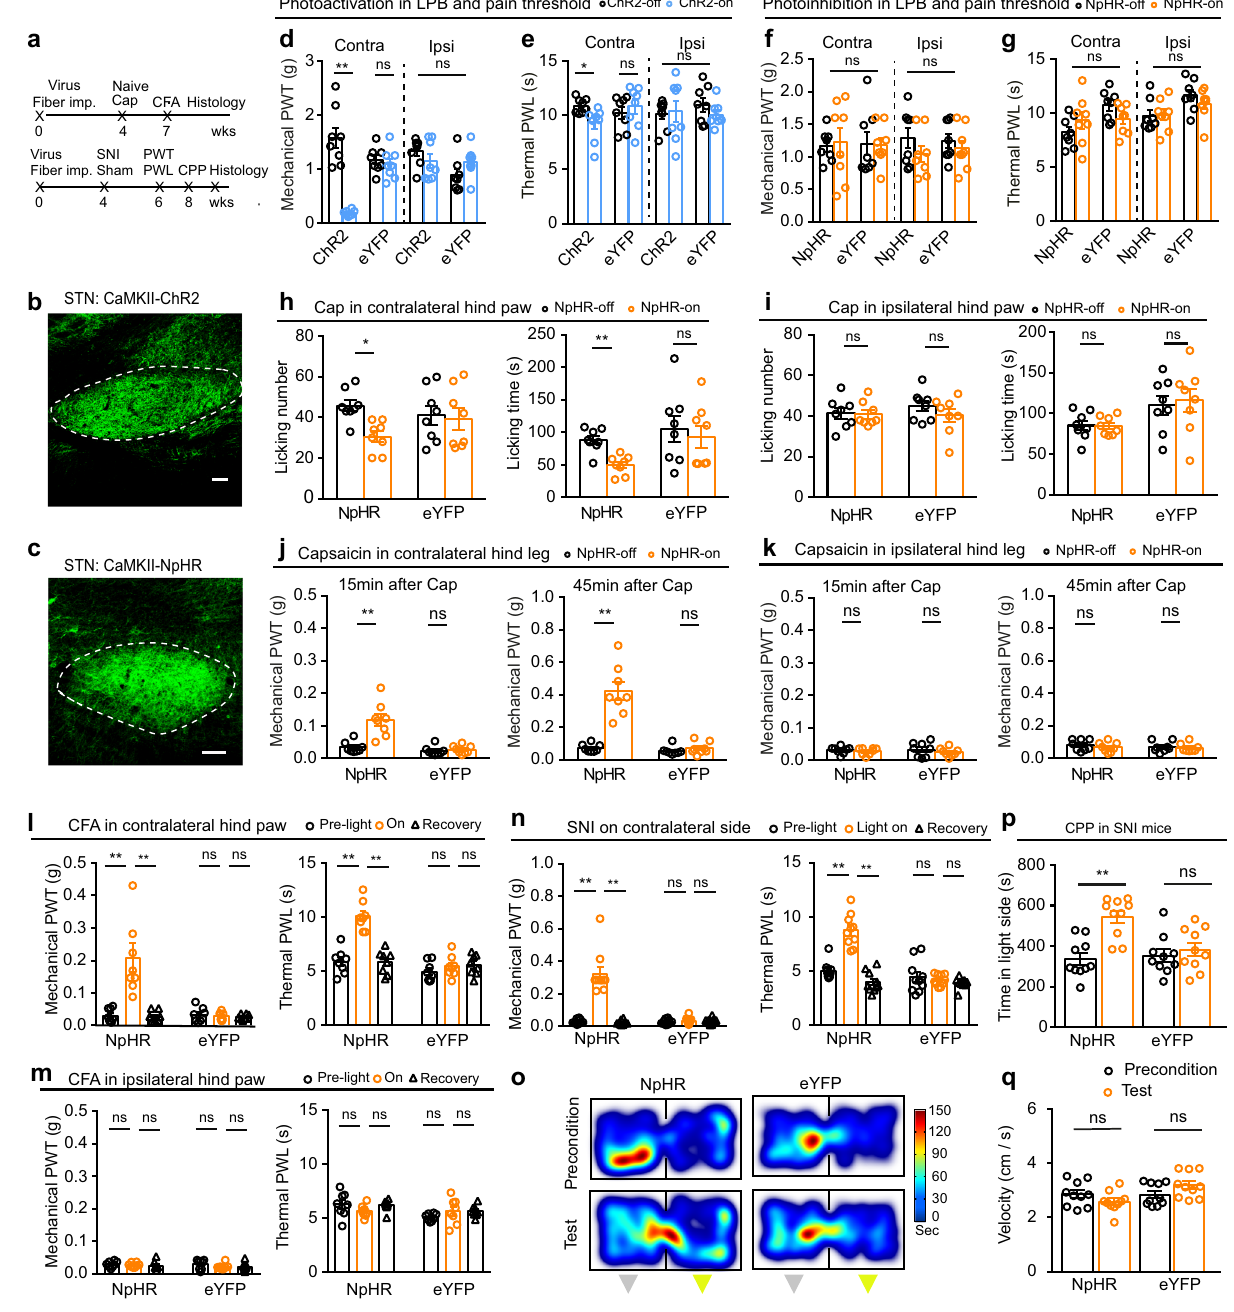
Fig. 7 | The STN – LPB projection modulates pain-like behaviors in female